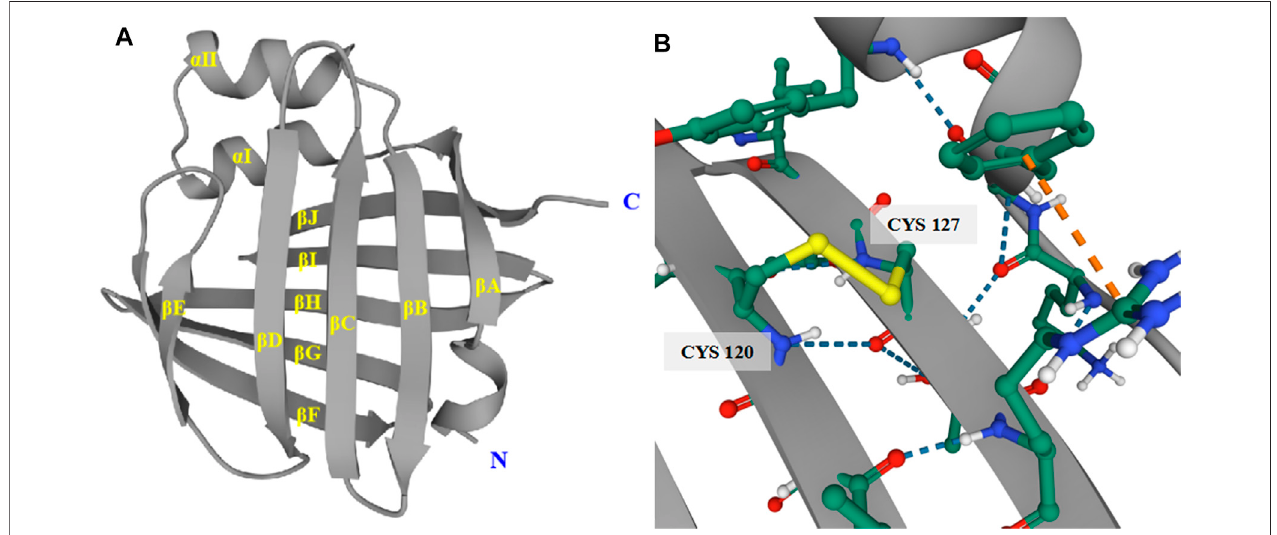
FIGURE4 | Tertiary structure ofhuman FABP5. (A) The tertiary structure ofFABP5 consists of2 α -helices and 10anti-parallel β -strands. (B) Thedisulphide bridge between cysteines 120 and 127 in FABP5 promotes protein stability.